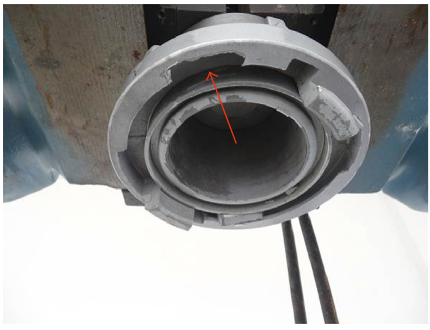
Figure 39: Fracture morphology of the fixed end of the